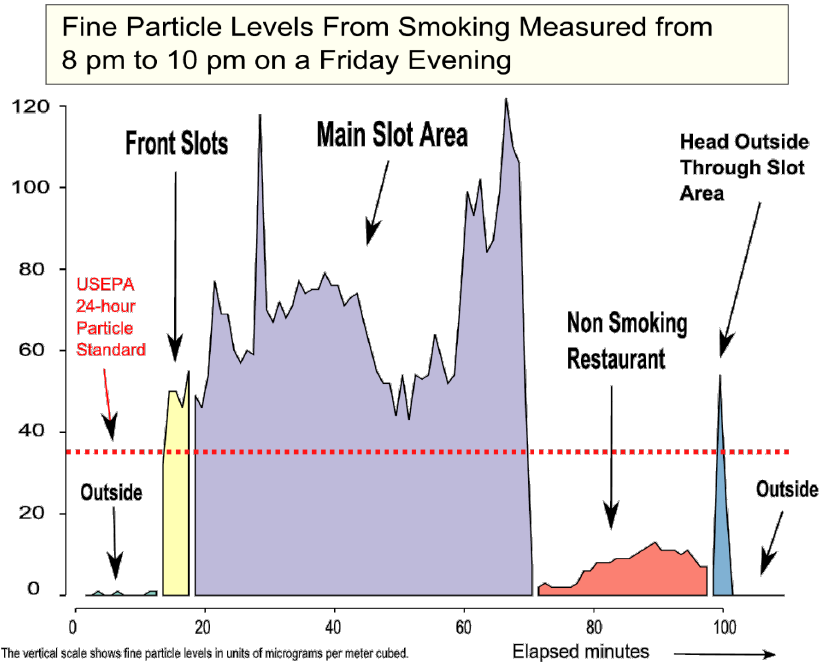
Figure 3. Sample presentation plot showing real-time 1-min fine particle (personal